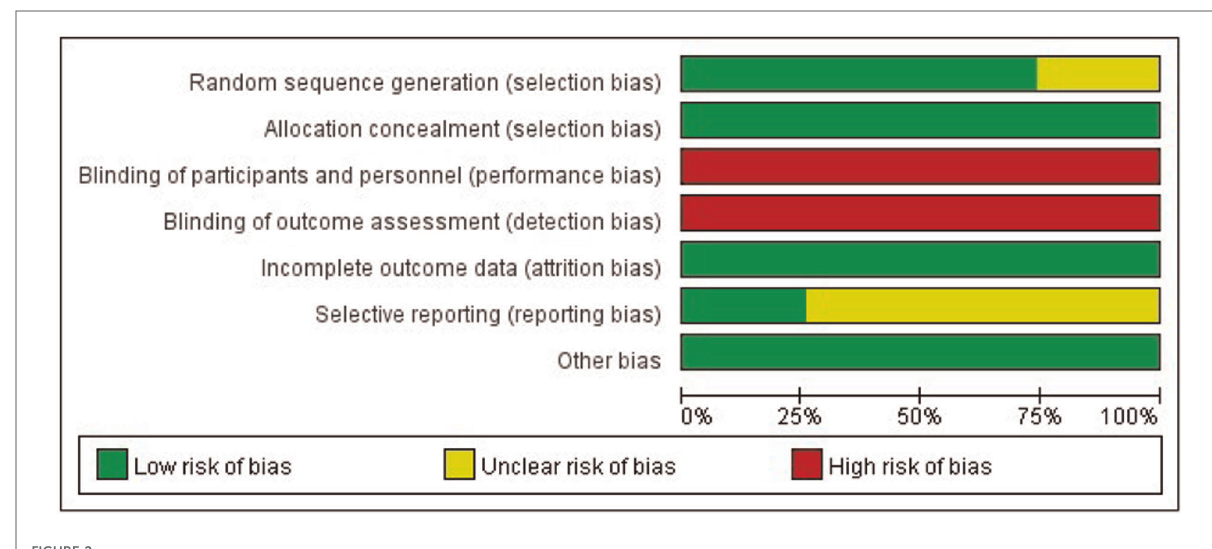
FIGURE 2 Risk of bias graph: review authors ’ judgements about each risk of bias item presented as percentages across all included